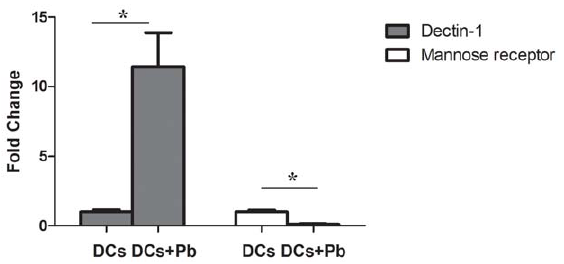
Figure 2. Relative quantification of dectin-1 and mannose receptor transcripts in dendritic cells infected with P.brasilien- sis . BALB/c bone marrow-derived DCs were cultured for 6 h with or without P. brasiliensis yeast cells (Pb). Then total RNA was extracted from the DCs and used in qRT-PCR assays. Fold change values were determined after each gene was normalized to the constitutively expressed RPS9 gene using the comparative threshold method. Data are reported as the mean 6 standard deviation. * P , 0.05.